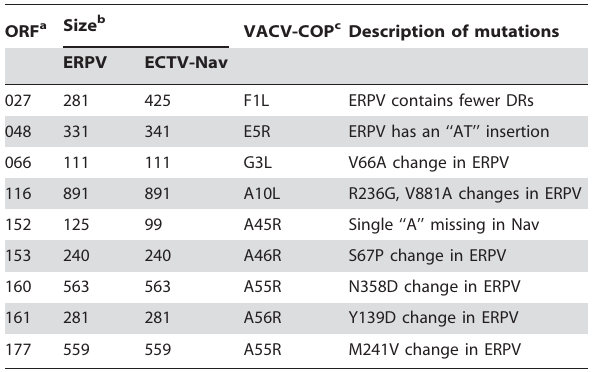
Table 2. Summary of ERPV mutations predicted to affect proteins relative to